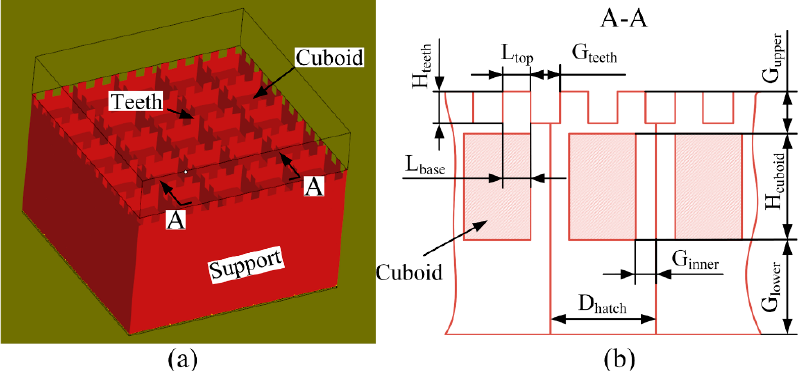
Figure 3. Block support structure with cuboids for heat dissipation: ( a ) three dimensional shape and ( b ) A-A local cross section sketch.